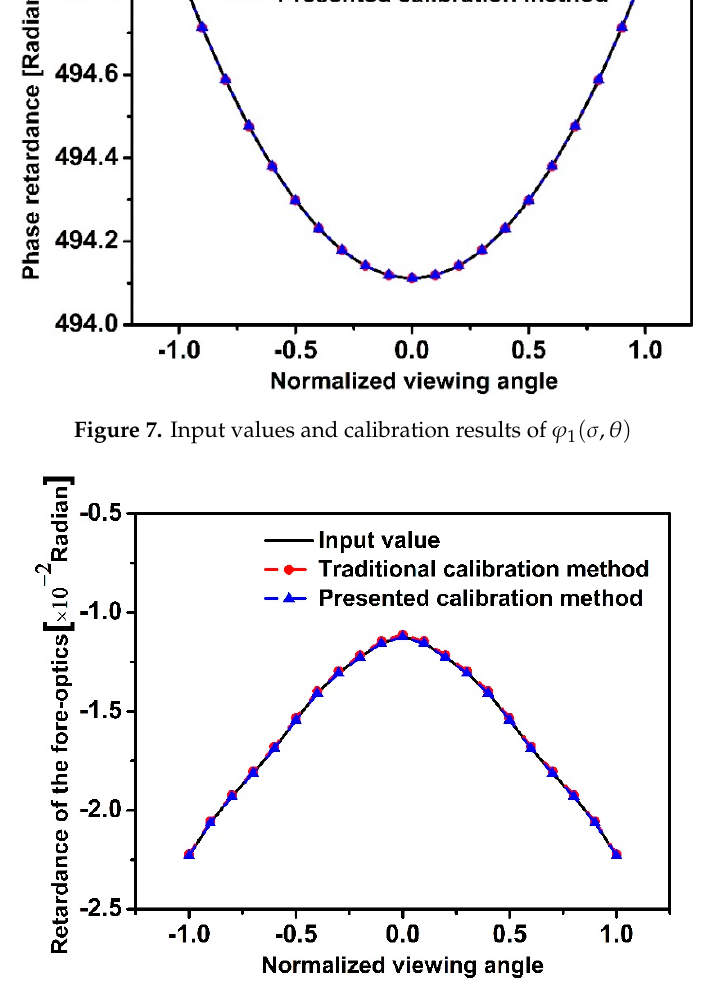
Figure 8. Input values and calibration results of the ratardance of the fore-optics.